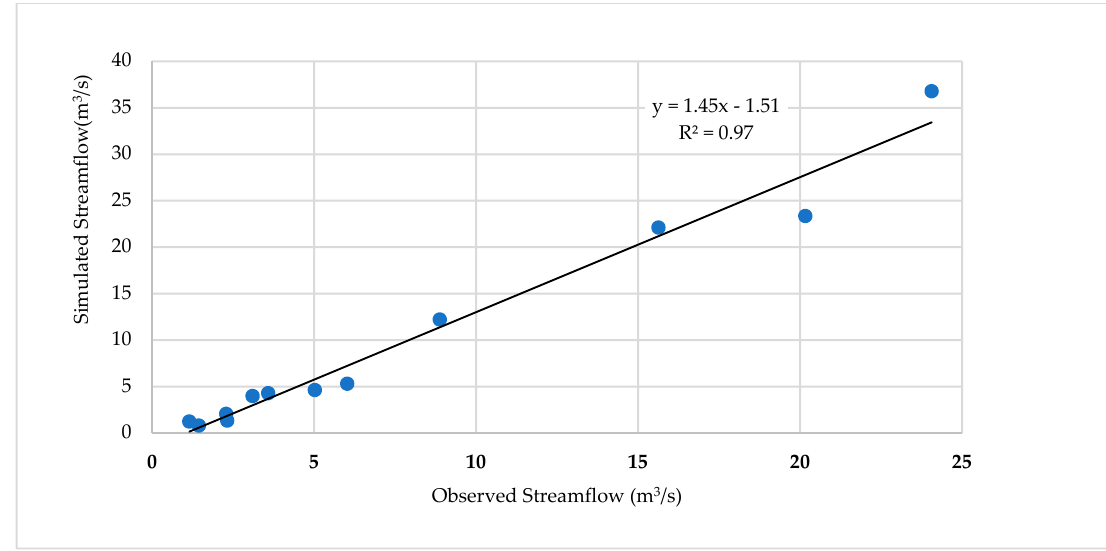
Figure 12. Comparison of observed and simulated streamflow using R 2 .